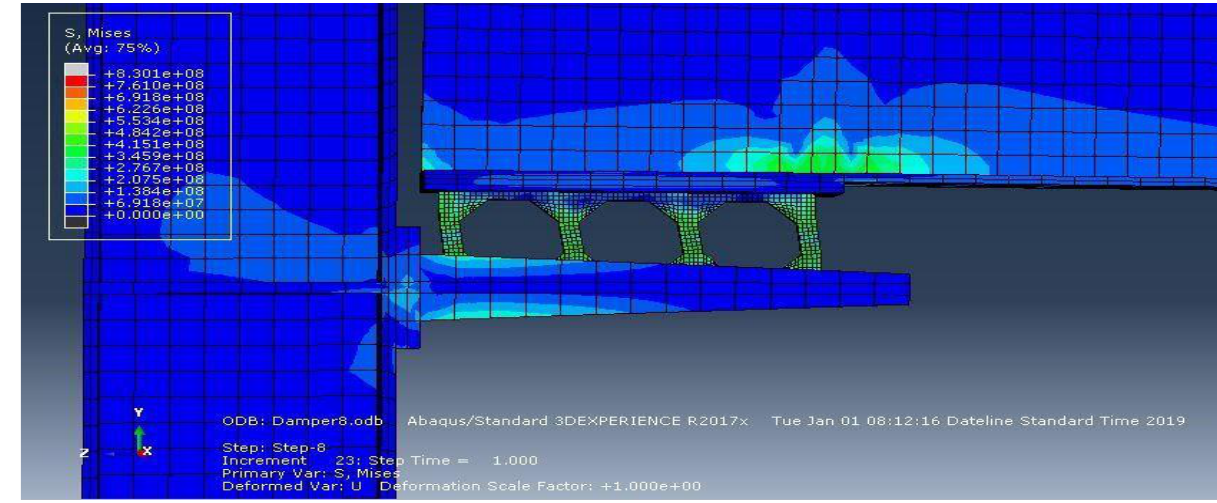
Figure 5. The shape of cubical slit damper after applied load in Abaqus software Energy exhausted capacity at the end flange can deform compatibility with repeated loads, such as tensile and compressive forces on the bottom flange. To restrict the damage to the connection element without causing damage to the main structural components, and as shown in Figure5, energy dissipation through the vertical struts of a triangle shape damper with varied data of moment against rotation studied using the (ABAQUS) program.